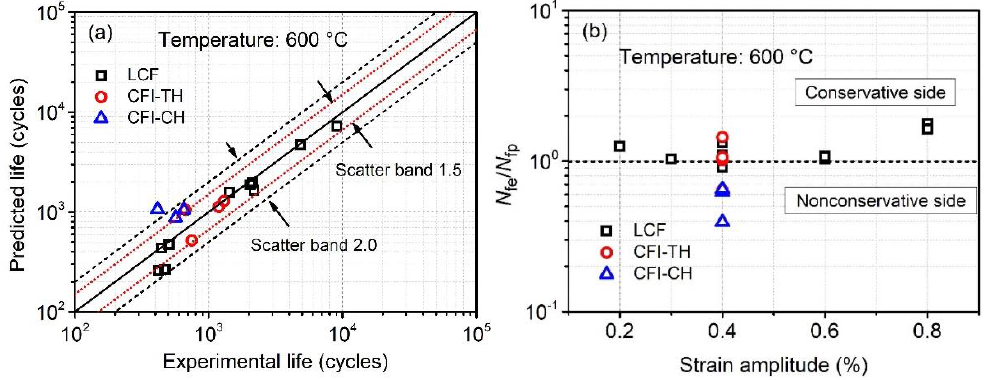
Figure 7. ( a ) Comparison between experimental life and predicted life using EB model, ( b ) the ratio of experimental life to predicted life versus different strain amplitudes.